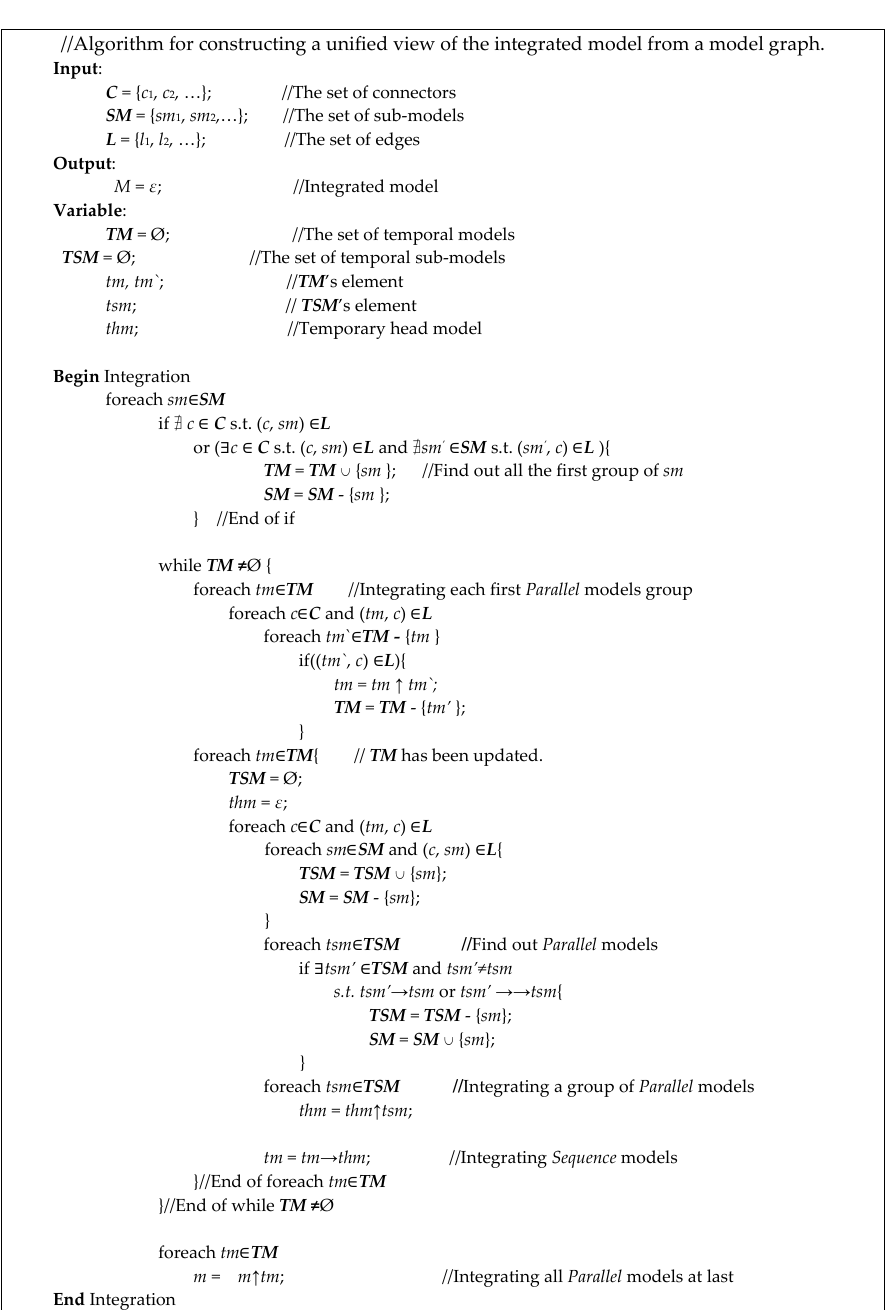
Figure 14. The algorithm for constructing a unified view of the integrated model from a model graph.